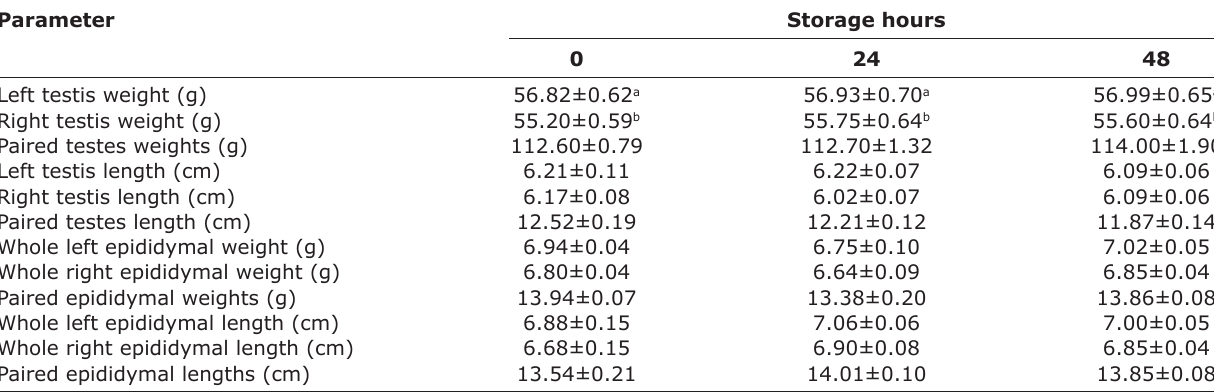
Table-1: Mean (±SEM) testicular and epididymal values from red Sokoto bucks’ testes collected post-mortem, processed without storage and stored at 4°C for 24, and 48 h. Parameter